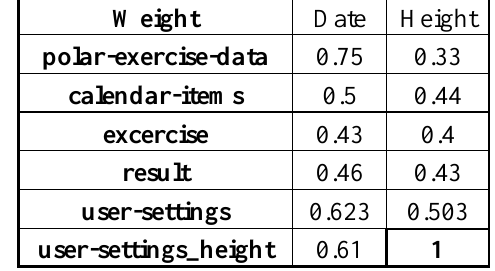
Table 7. Similarity matrix for pair of sets of neighbors ( N